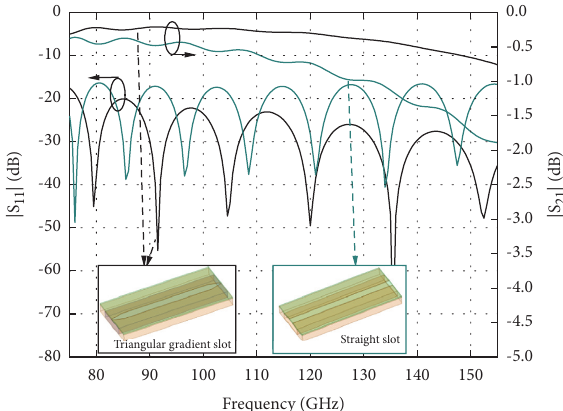
Figure 9: Simulated S-parameters of straight SRW and triangular gradient